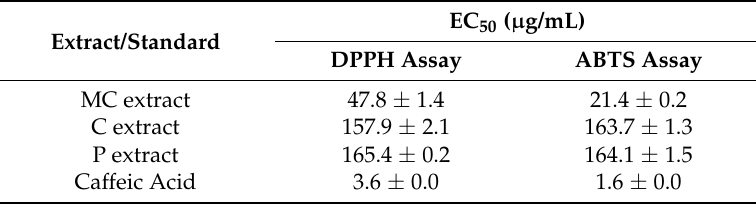
Table 3. Radical scavenger capacity of the investigated extracts.